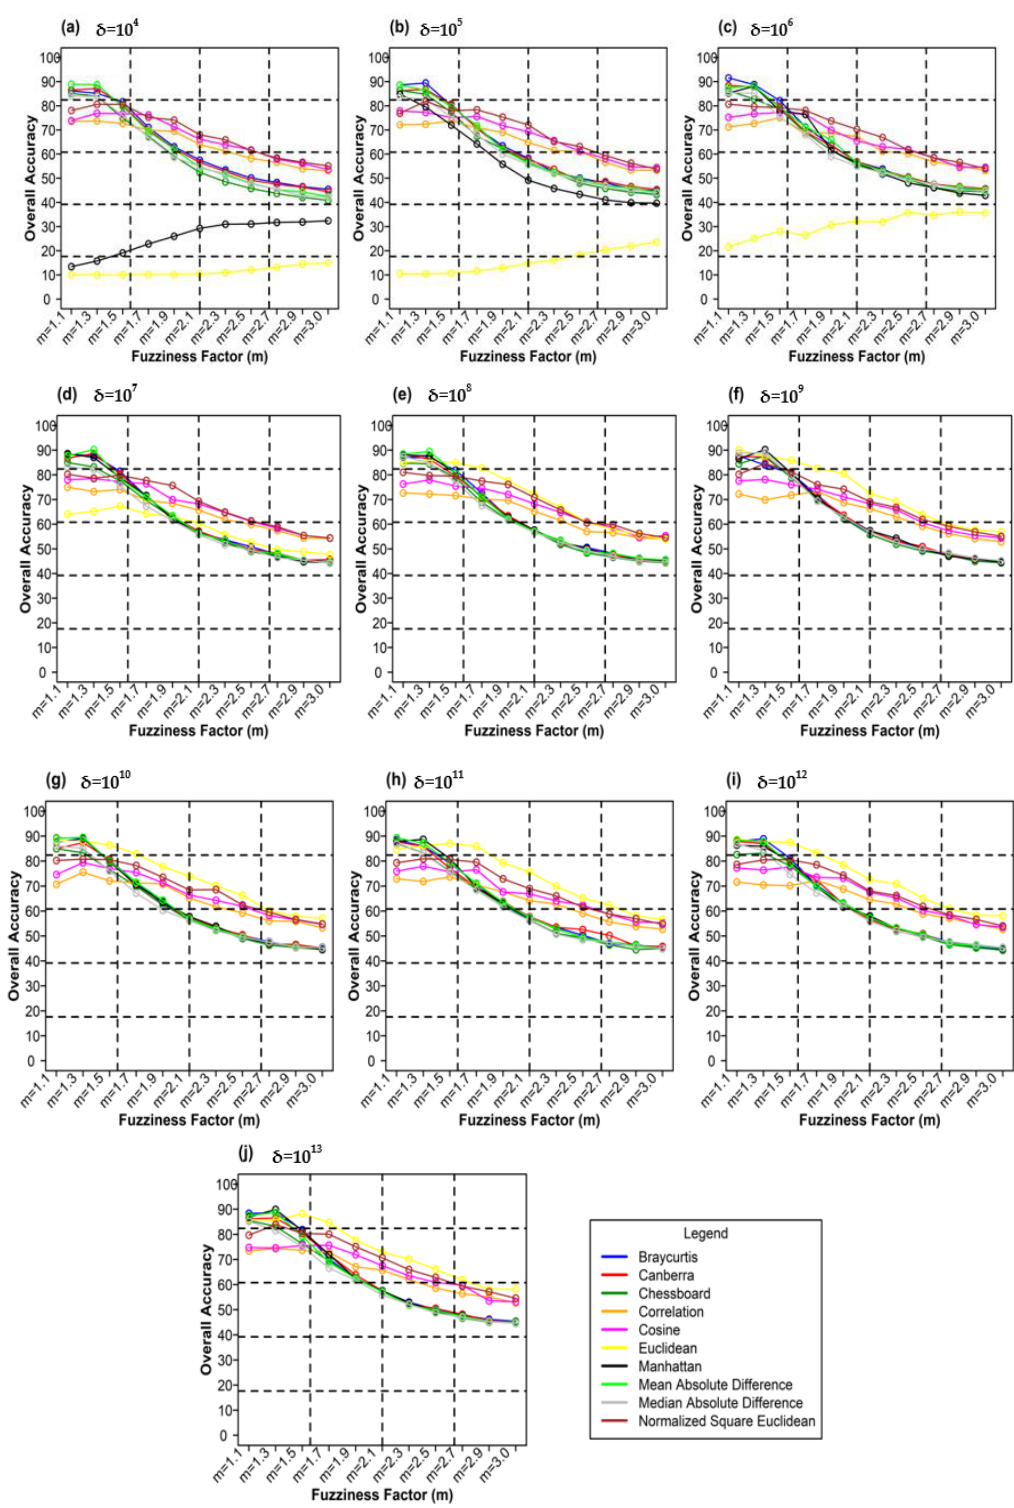
Figure 12. Comparison of overall accuracy in ADNLICM classifier for applying different distance measures, m (1.1–3.0), and ( a – j ) for site 1 (Haridwar).